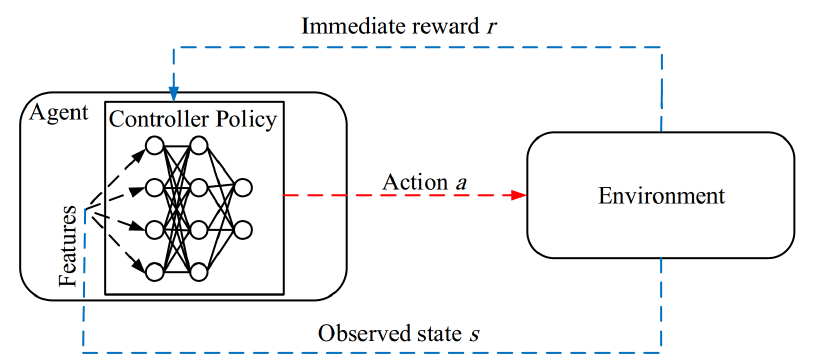
Figure 8. Deep reinforcement learning